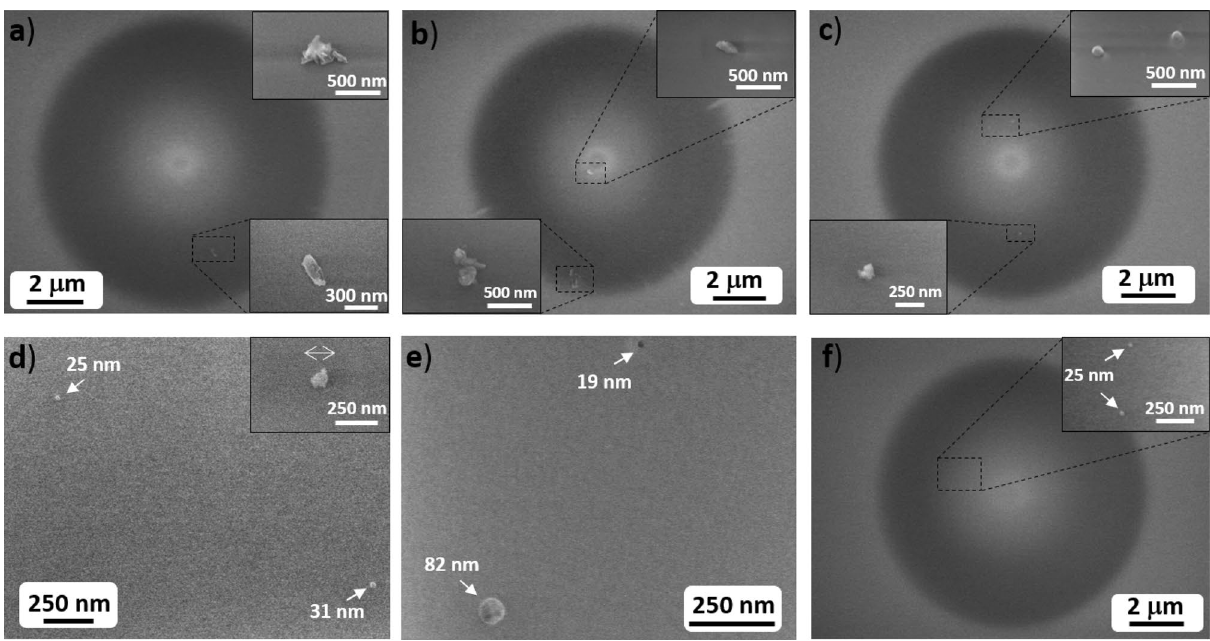
Figure 2. Representative SEM micrographs of fibers drawn from preform D at: ( a ) 1870 °C, ( b ) 1890 °C, ( c ) 1955 °C, ( d ) 2020 °C, ( e ) 2065 °C and ( f ) 2100 °C. The insets show in more detail the characteristic morphology and size of particles at the corresponding drawing